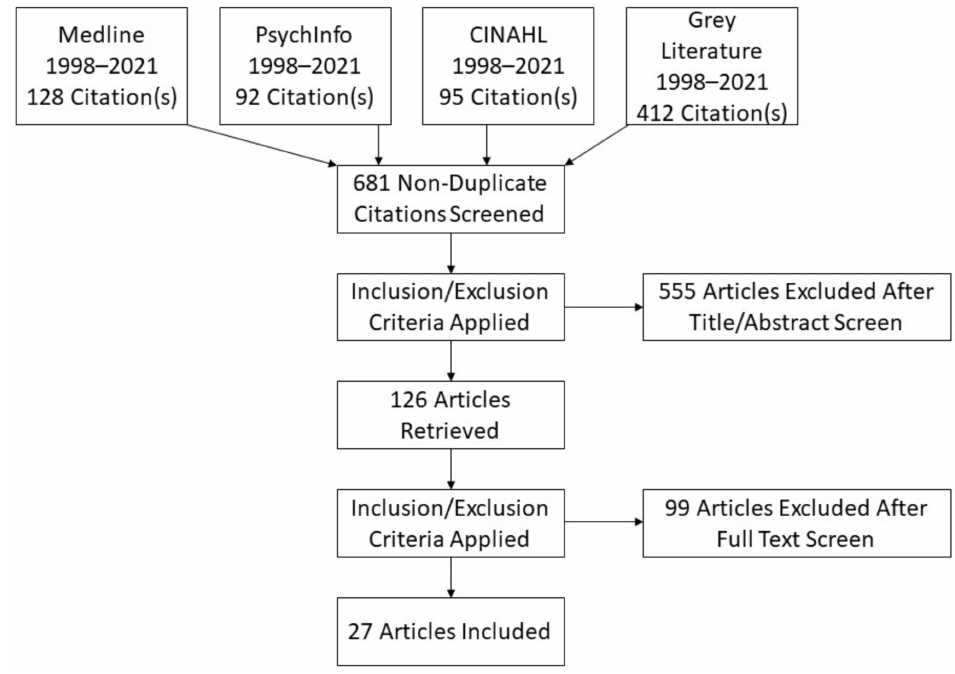
Figure 1. PRISMA Flow